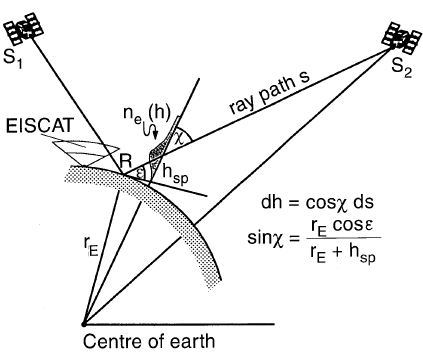
Fig. 1. Scheme of the ray-path geometry between GPS satellites S (cid:49)(cid:44)(cid:50) and a receiver R. The mapping function M ( (cid:101) ) is related to the zenith angle (cid:115) of the ray path s at the pierce point with the assumed ionospheric shell at the height h (cid:115)(cid:112) Fig. 2. Differential measurements of pseudorange (p (cid:50)